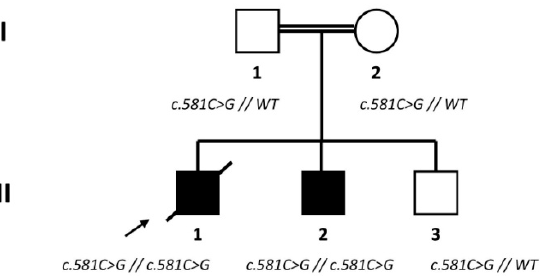
Figure 1. Pedigree of patient’s family with GDAP1 genotype; the propositus (“patient”) is indicated by the black arrow (WT: wildtype).